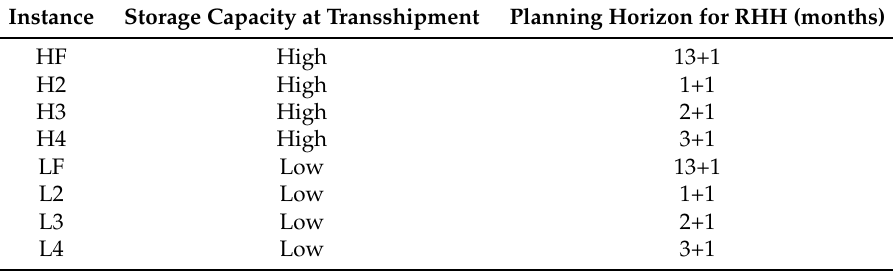
Table 2. Overview of test instances.